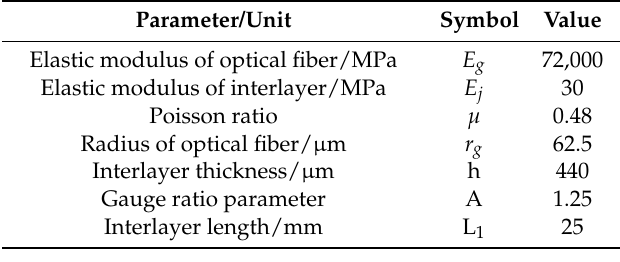
Table 1. Physical and mechanical parameters.